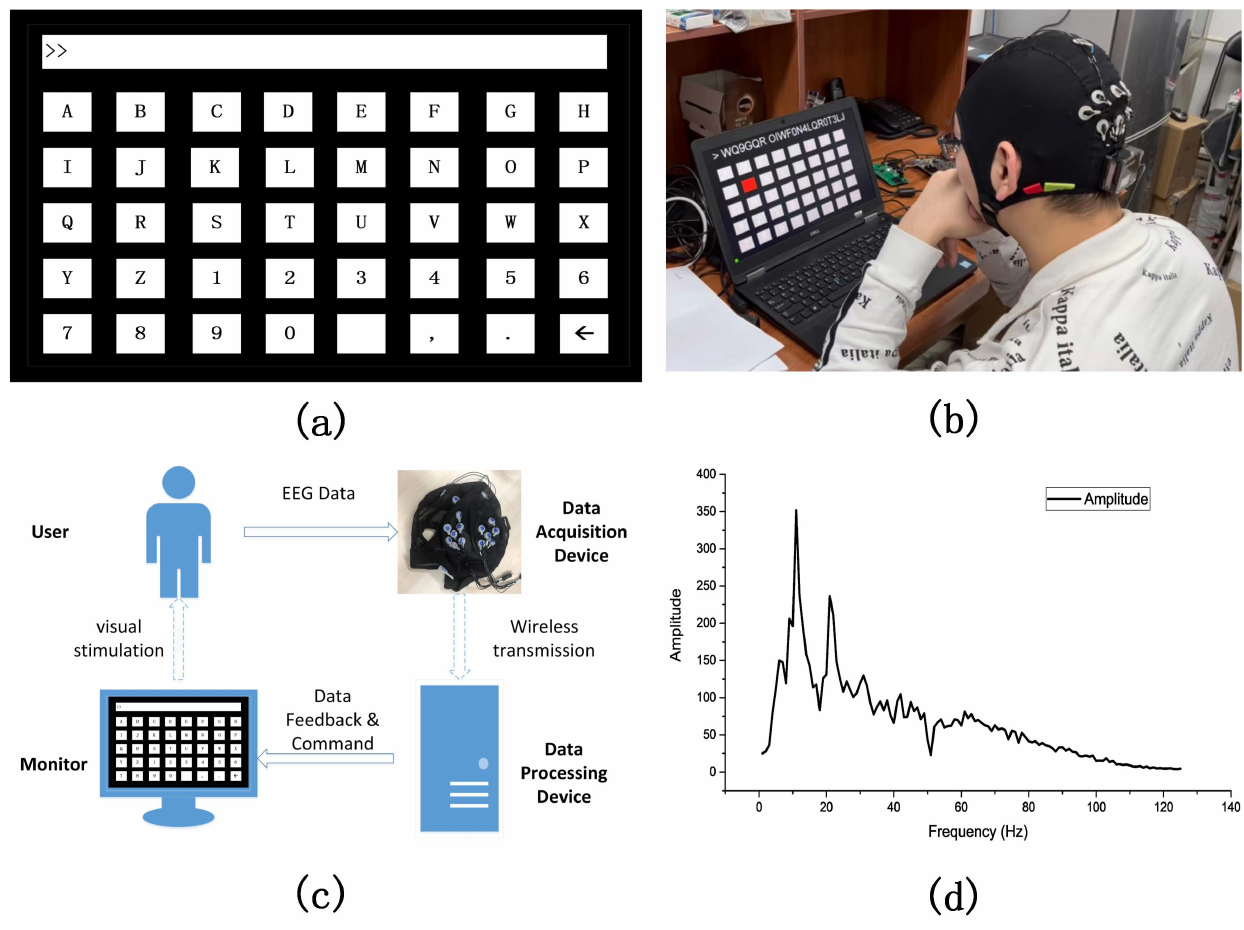
Figure 1. Schematic diagram of the SSVEP experiment: ( a ) The layout resembles a conventional keyboard with 26 alphabets, 10 numbers, and 4 non-alphanumeric keys (space, comma, dot, and backspace) aligned in 5 rows. The upper rectangle is designed to present the input character. ( b ) A subject is using the SSVEP system. ( c ) Schematic diagram of SSVEP data transmission. ( d ) Amplitude spectrum of SSVEP